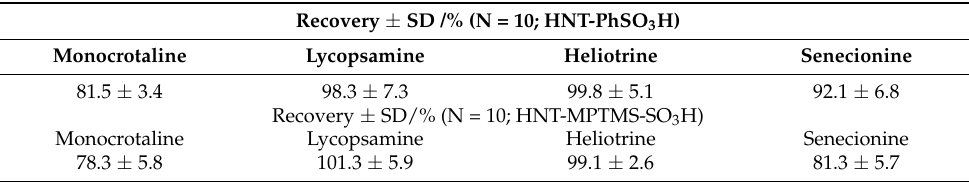
Table 2. Recoveries of an aqueous 10.0 µ g L − 1 pyrrolizidine alkaloid standard mixture after solid phase extraction using HNT-PhSO 3 H and HNT-MPTMS-SO 3 H as solid materials.